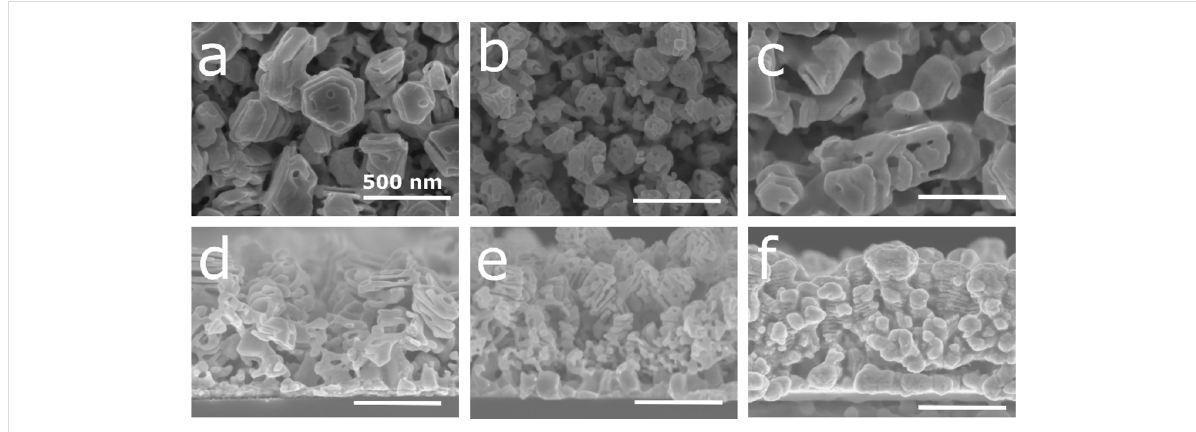
Figure 6: (a–c) Plan view and (d–f) cross-section SEM images of the Ag–Al alloy thin film dealloyed for 60 min in NaOH at 10 wt % with an initial com- position of (a, d) 18, (b, e) 30, and (c, f) 36 atom % of Ag. Scale bar: 500 nm.